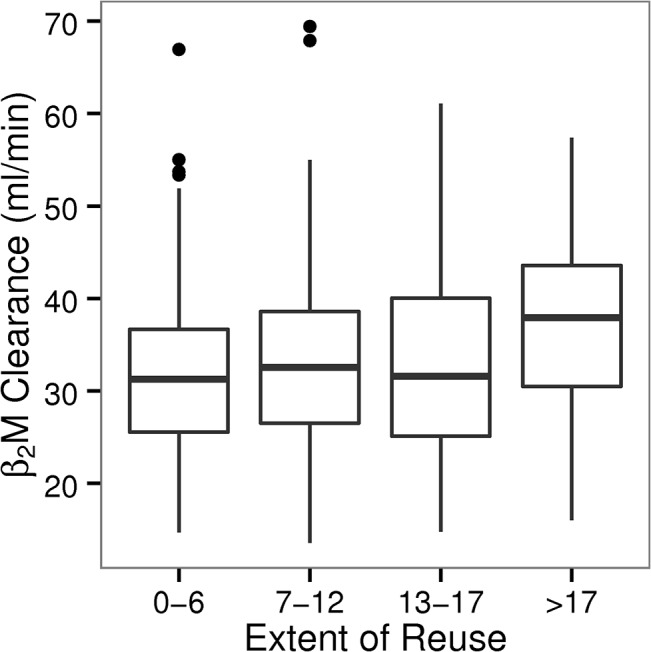
Distribution of predicted β2M clearance across quartiles of membrane reuse in HEMO.Controlling the extent of reuse by the HEMO study protocol yielded average clearances that were equivalent across reuse quartiles in patients receiving HF dialysis. Average β2M clearance by HF dialyzers in the 2nd to 4th reuse quartile, was 1.26±1.02 (p = 0.21), 1.47±1.00 (p = 0.14) and 5.41±1.03 (p<0.001) ml/min higher relative to the first quartile (31.8±0.69 ml/min).